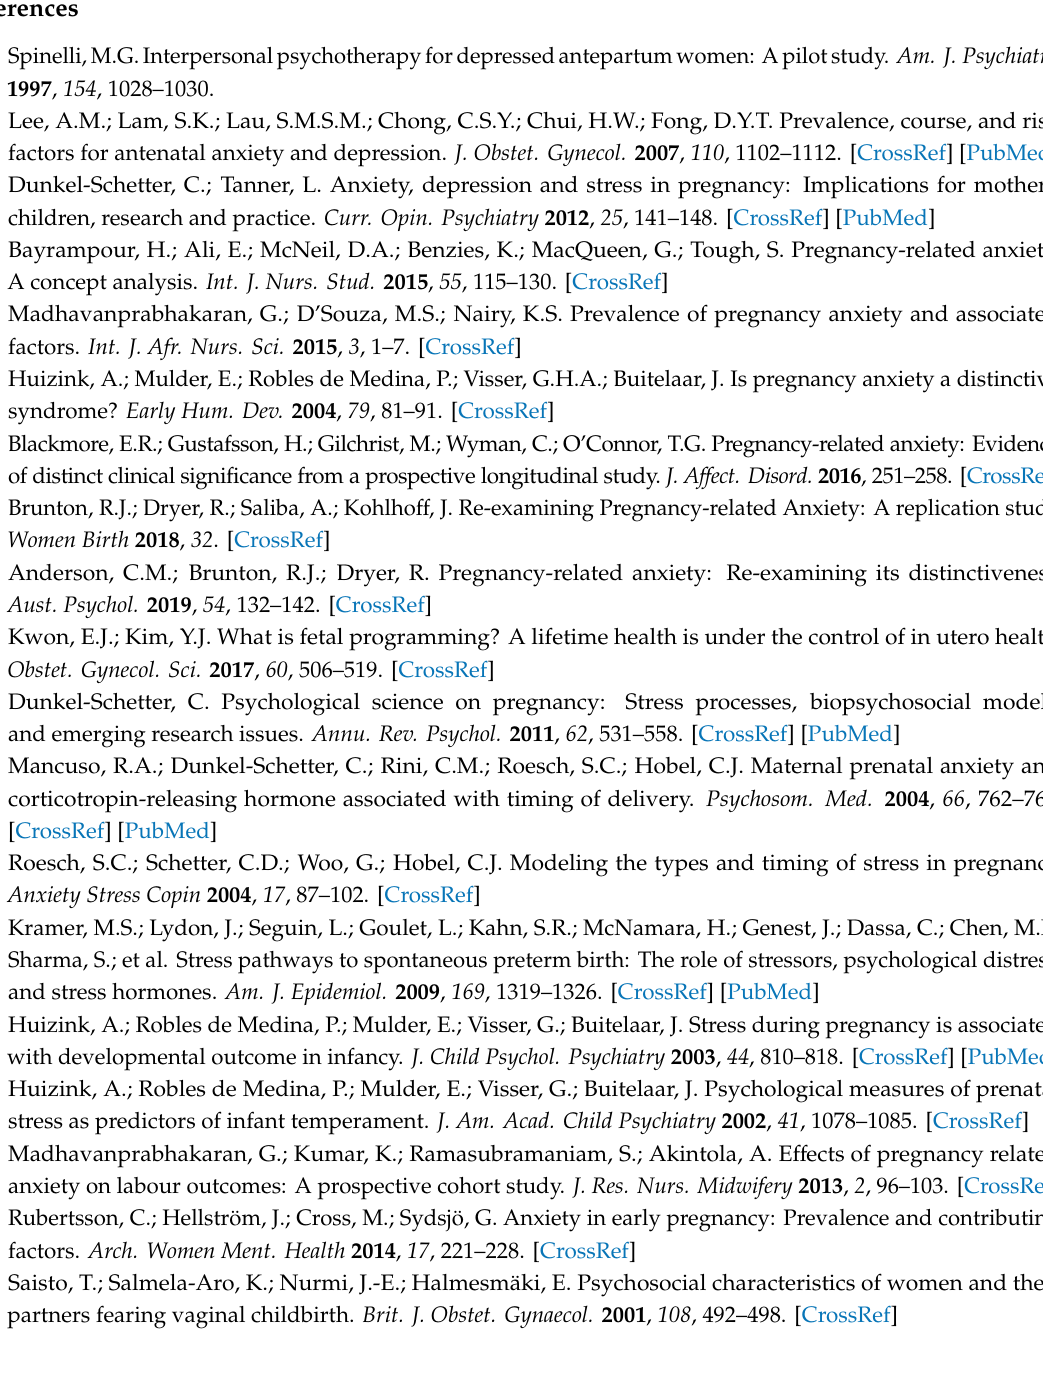
Table S1. MANOVA: PrAS and PPES-R. Table S2. MANOVA: PrAS subscales and PPES-R